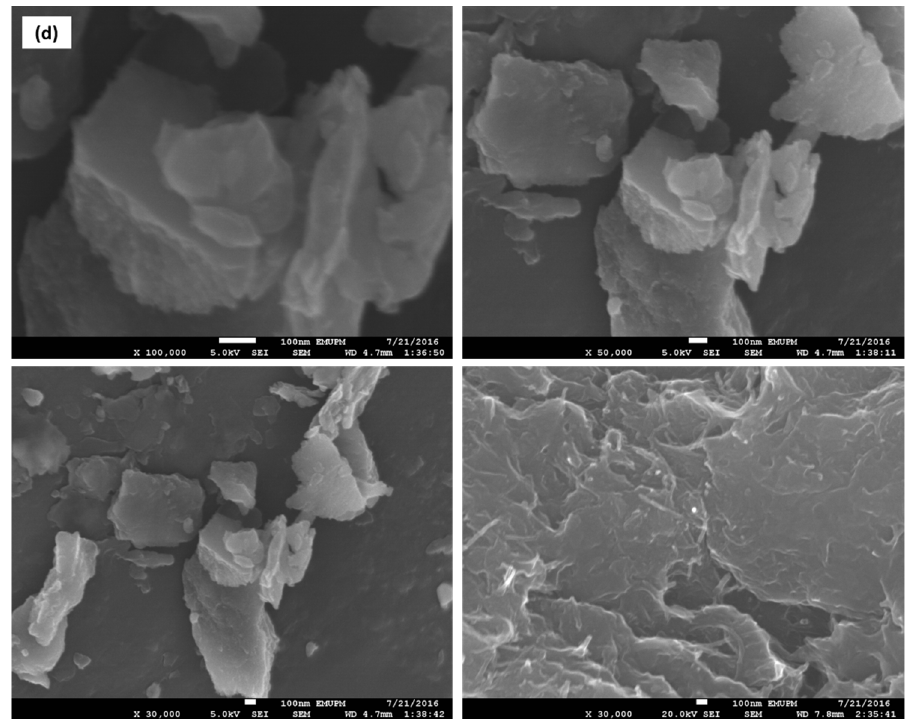
Figure 4. FESEM images of ( a ) commercial MWCNTs, ( b ) MWCNT-MA, ( c ) MWCNT-MB and ( d ) MWCNT-MC with different resolution and diameter distribution histogram.